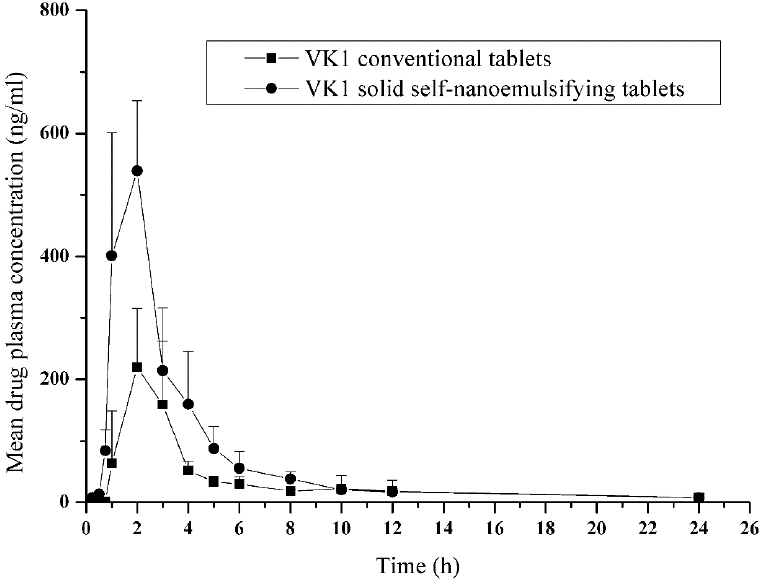
Figure 11. Plasma profile of VK1 in beagle dogs after a single oral administration of solid self- nanoemulsifying VK1 tablets and conventional VK1 tablets ( n = 6).